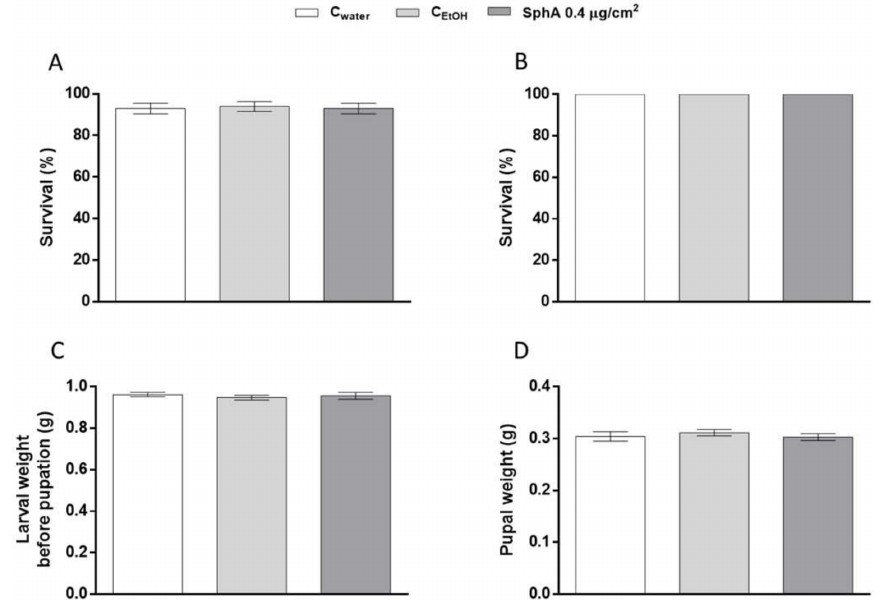
Figure 2. Effect of SphA topical application on S. littoralis larvae. SphA sprayed at the concentration of 0.4 µ g/cm 2 on S. littoralis larvae did not affect the survival rate of 2nd instar ( A ) (Log-Rank test: χ 2 = 0.1159, p = 0.9437, dF = 2) and 5th instar larvae ( B ), as well as the larval weight before pupation ( C ) (One Way ANOVA: F (2, 93) = 0.2838, p = 0.7536) and the pupal weight ( D ) (One Way ANOVA: F (2, 93) = 0.3914, p = 0.6772). Values are reported as means ±